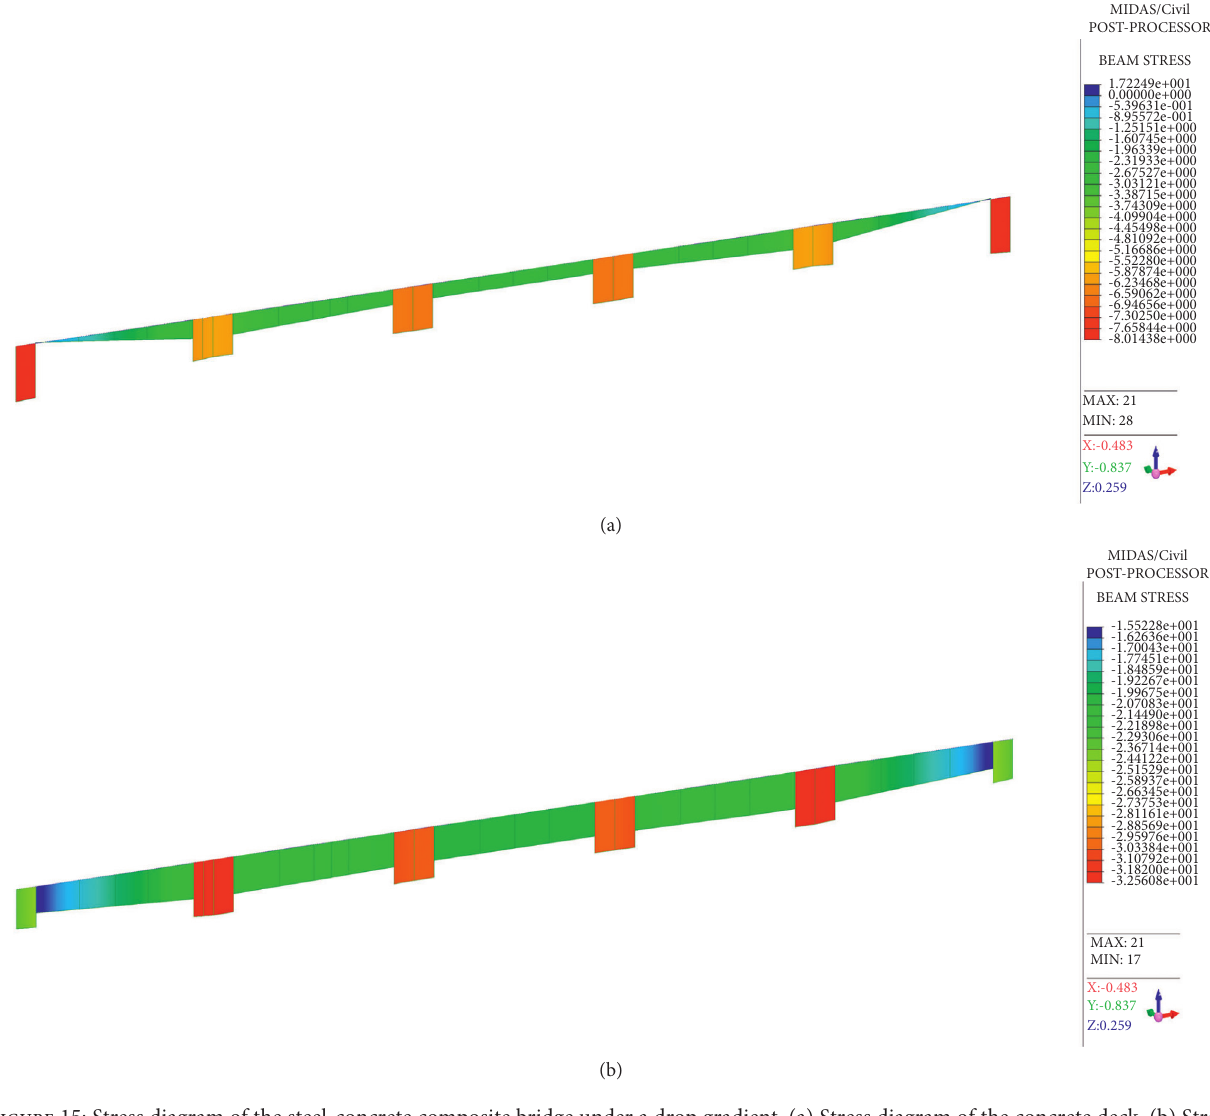
Figure 15: Stress diagram of the steel-concrete composite bridge under a drop gradient. (a) Stress diagram of the concrete deck. (b) Stress diagram of the steel